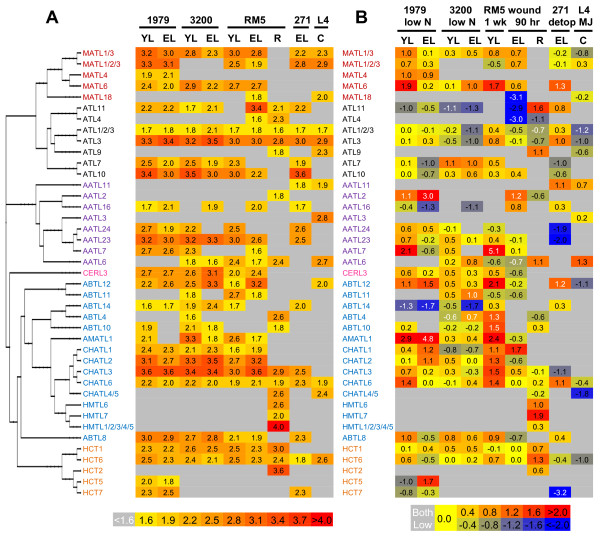
Expression of BAHD Acyltransferases in Populus Tissues, Organized by Phylogenetic Relationship. A: Expression of BAHD acyltransferase genes across tissues and genotypes. B: Stress responses of BAHD acyltransferase gene expression across tissues and genotypes. Expression data or ratios (stressed vs. control samples) were log-transformed and visualized in heatmaps (see Methods). Genes are organized by phylogenetic relationship and labelled by the clade color in Figure 1. Genotypes analyzed included: P. fremontii × angustifolia clones 1979, 3200, and RM5, and P. tremuloides clones 271 and L4. Tissues analyzed included: young leaf (YL), expanding leaf (EL), root tips (R), and suspension cell cultures (C). Stress treatments included: nitrogen limitation (low N), leaf wounding (wound, sampled either 1 week or 90 hours after wounding), removal of shoot up to leaf plastochron index three (detop, 90 hours after removal), and methyl jasmonate elicitation (MJ) [24]. White text indicates that raw hybridization intensity for either control (for upregulated genes) or stressed treatment (for downregulated genes) samples was below the quantitation limit (see Methods).